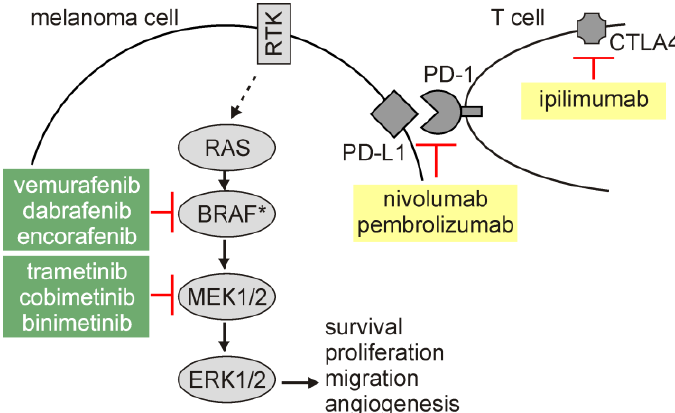
Figure 1. Targeted therapeutics and immunotherapy used in the treatment of melanoma patients. Melanoma cells exert hyperactivation of the RAS/RAF/MEK/ERK signaling pathway that regulates different cellular programs, including survival. Targeted therapeutics (shown in green background) inhibit activity of either mutated BRAF (BRAF*, V600E is the most frequent amino acid substitution) or MEK1/2. BRAFi and MEKi are used as a combinatory treatment regimen. Immunotherapy (shown in yellow background) includes checkpoint inhibitors: antibodies blocking either PD-1 (programmed death-1) or CTLA4 (cytotoxic T-lymphocyte associated protein 4). Both targets for immunotherapy are physiological inhibitors of T cell-mediated immune response. RTK, receptor tyrosine kinase.